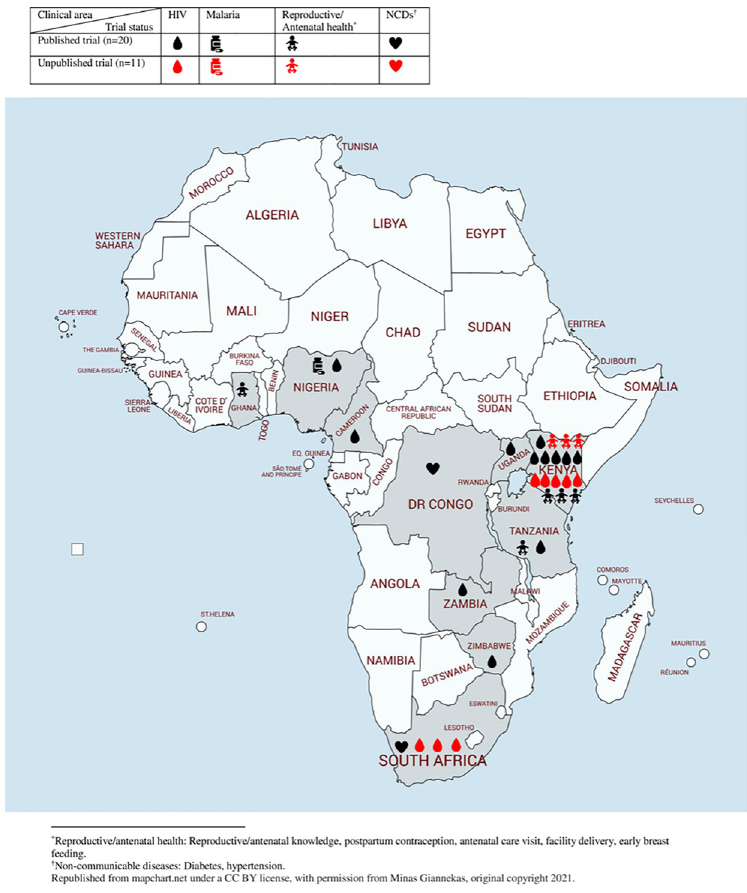
Fig 2. Overview of two-way text message trials in Africa according to clinical area and trial status. two-way text messages that promoted contraception use and compared these to a control group receiving a sham text message (i.e. text messages with nutrition-focused-content) on the incidence of unintended pregnancies among sex workers in Kenya. They found no difference in the incidence of unintended pregnancy over 12 months of follow-up in the intervention group compared to the control group (hazard ratio (HR): 0.98; 95% CI: 0.7 to 1.4) [35].” Four trials reported outcomes related to HIV. One trial investigated the effect of two-way text messages (intervention) compared to routine in-person visits (standard care) for post- operative follow-up among male circumcision patients Zimbabwe and did not find any signifi- cant difference in adverse events between groups (risk difference (RD): 1.04% (p = 0.32)) [22]. Another trial reported that a two-way text-message intervention did not improve HIV medi- cine adherence (measured as continuous outcome) in Uganda compared to controls (mean proportion of pills taken : 0.64 versus mean : 0.67 (p = 0.15) [27]. Further, two trials two-way control assessed HIV medicine adherence and appointment attendance dichotomously but did not report the required patient and event data for be included in the meta-analyses. One of these trials was an unpublished trial set in South Africa (results recorded in clinicaltrials.gov) found a marginally effect in the two-way text message group compared to the control group (OR: 1.9; 95% CI: 0.9 to 4.2) [41]. The other trial was 3-arm trial on prevention of mother-to-child trans- mission of HIV in Kenya [44]. The trial found that two-way text messages did not improve on-